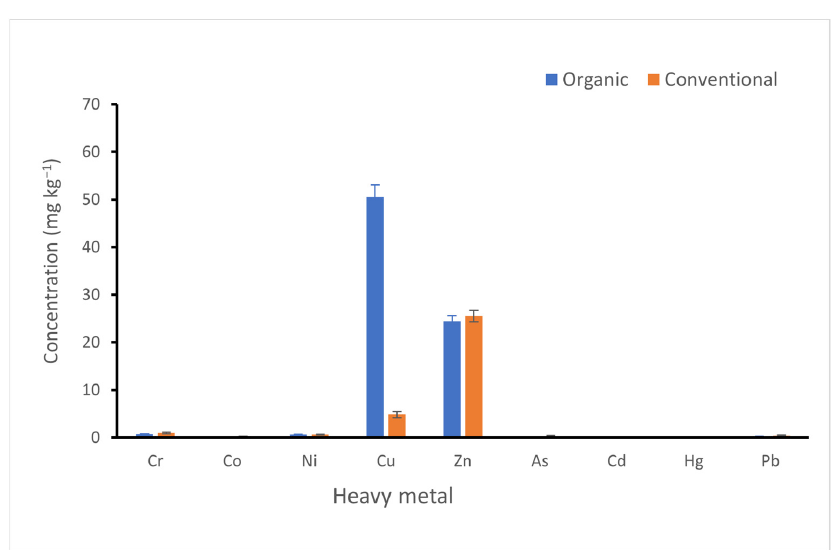
Figure 4. Influence of agricultural practices on heavy metal uptake by plant samples from vineyards of the Cape Winelands.